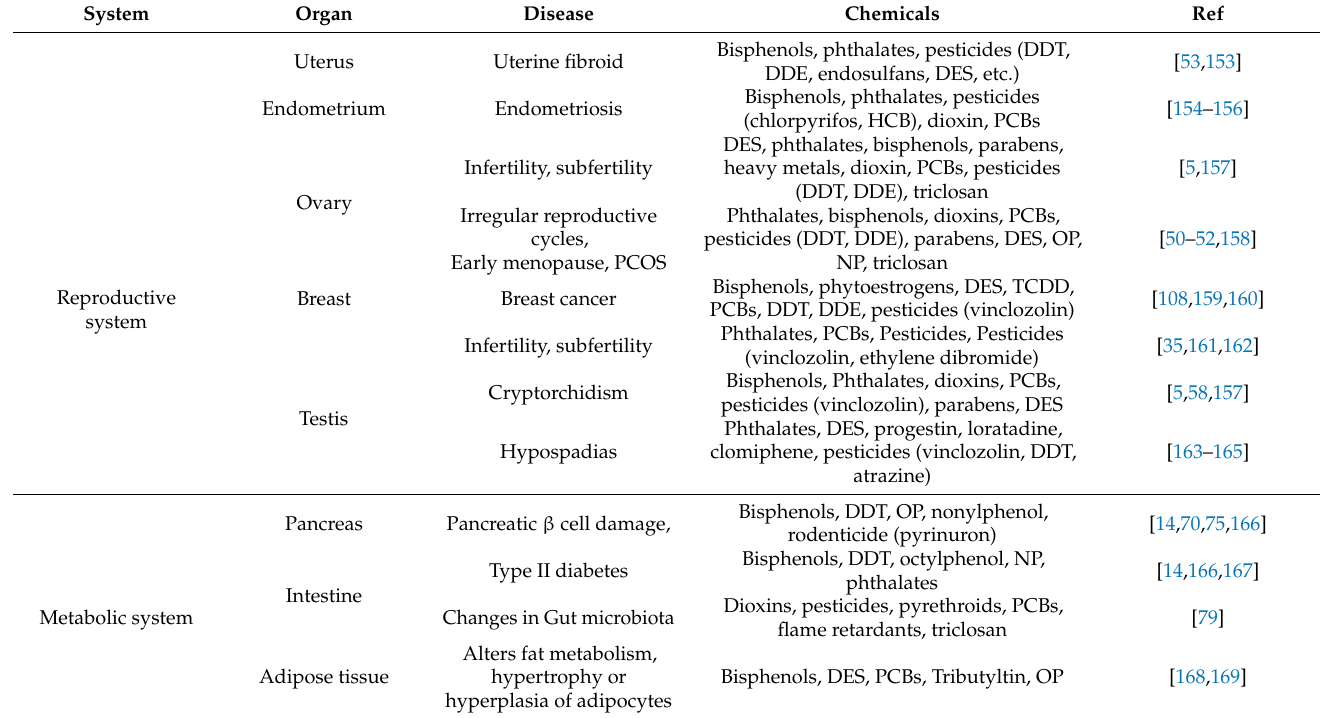
Table 1. Summaries of the EDCs–disease relationship on